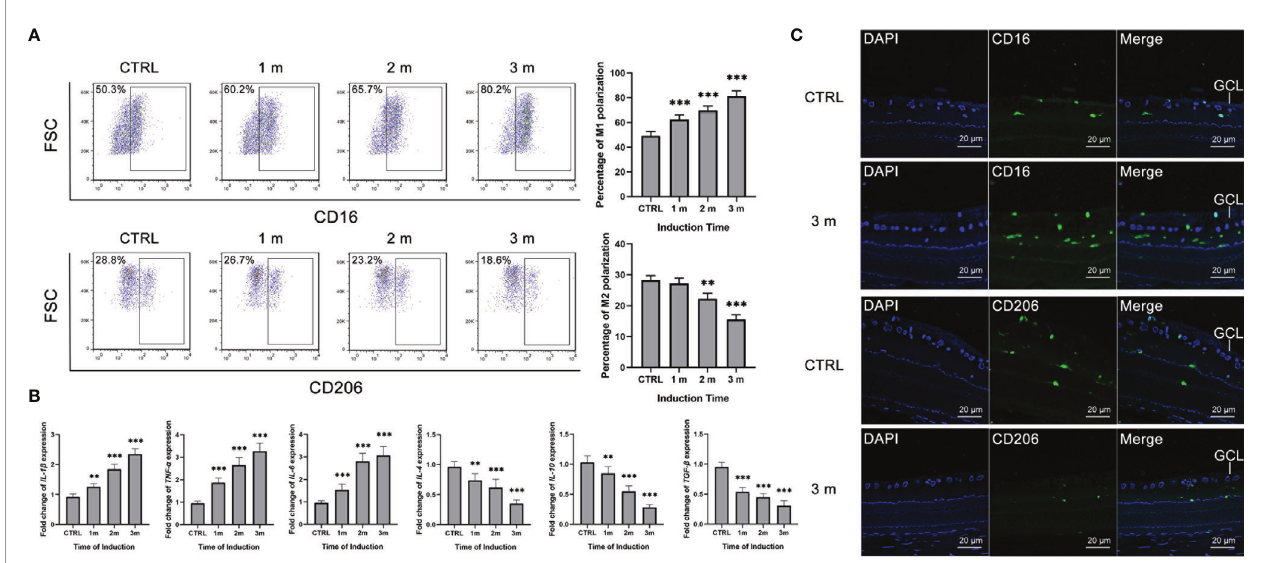
FIGURE 1 | Increased M1 polarization but decreased M2 polarization of retinal microglia in diabetes rats. (A) The percentage of CD16 + M1 microglia increased from 0 to 3 months after STZ induction. The percentage of CD206 + M2 microglia decreased at the 2 and 3 months after STZ induction. (B) The mRNA levels of IL-1 b , IL-6 and TNF- a increased from 0 to 3 months after STZ induction. The mRNA levels of IL-4, IL-10 and TGF- b decreased from 0 to 3 months after STZ induction. (C) The 3 months after STZ induction group have more CD16 + M1 microglia but fewer CD206 + M2 microglia compared to the control group. Values are presented as the mean ± SD. ** indicates P < 0.01, and *** indicates P <